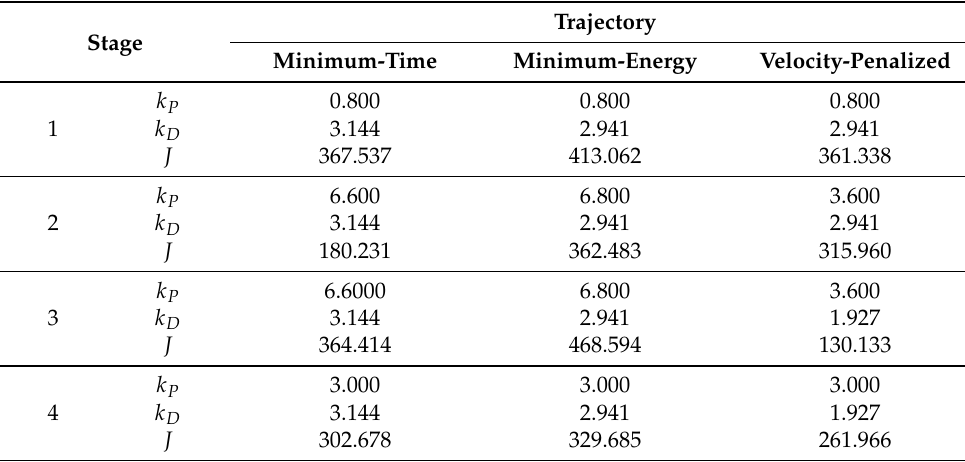
Table 2. Optimization of landing on the basis of IMU readings—12s